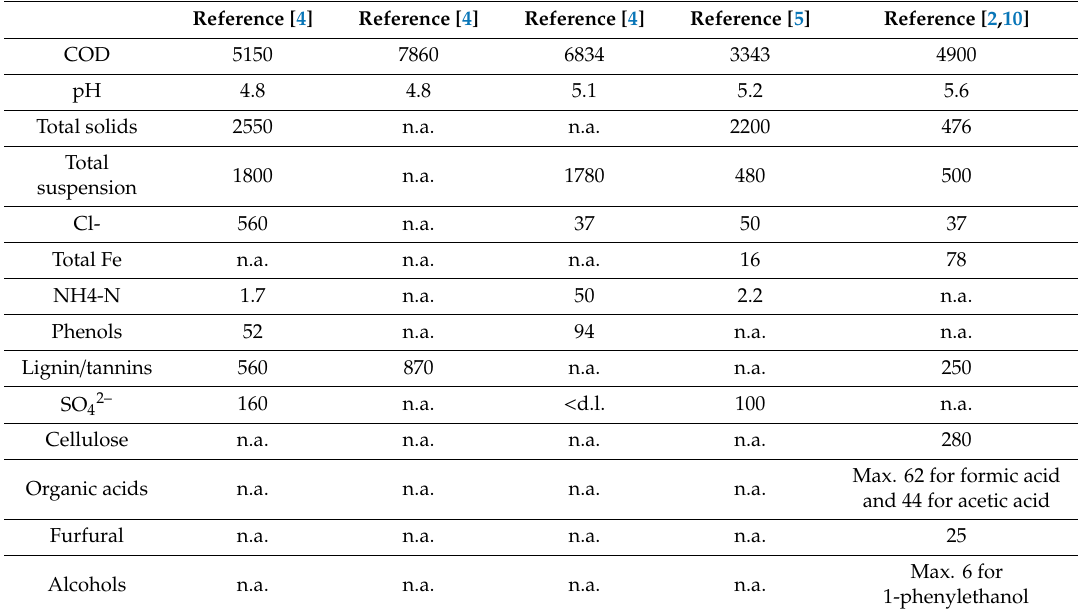
Table 1. Chemical composition of wastewater generated during wood hydrothermal treatment, sampled from di ff erent plants, in milligrams per liter (mg /